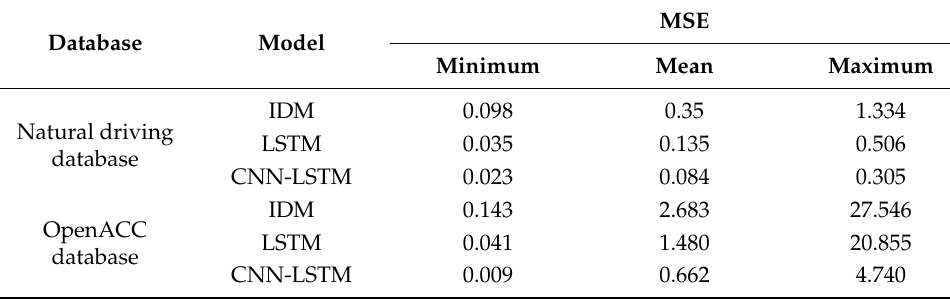
Table 6. Statistical results of speed simulation